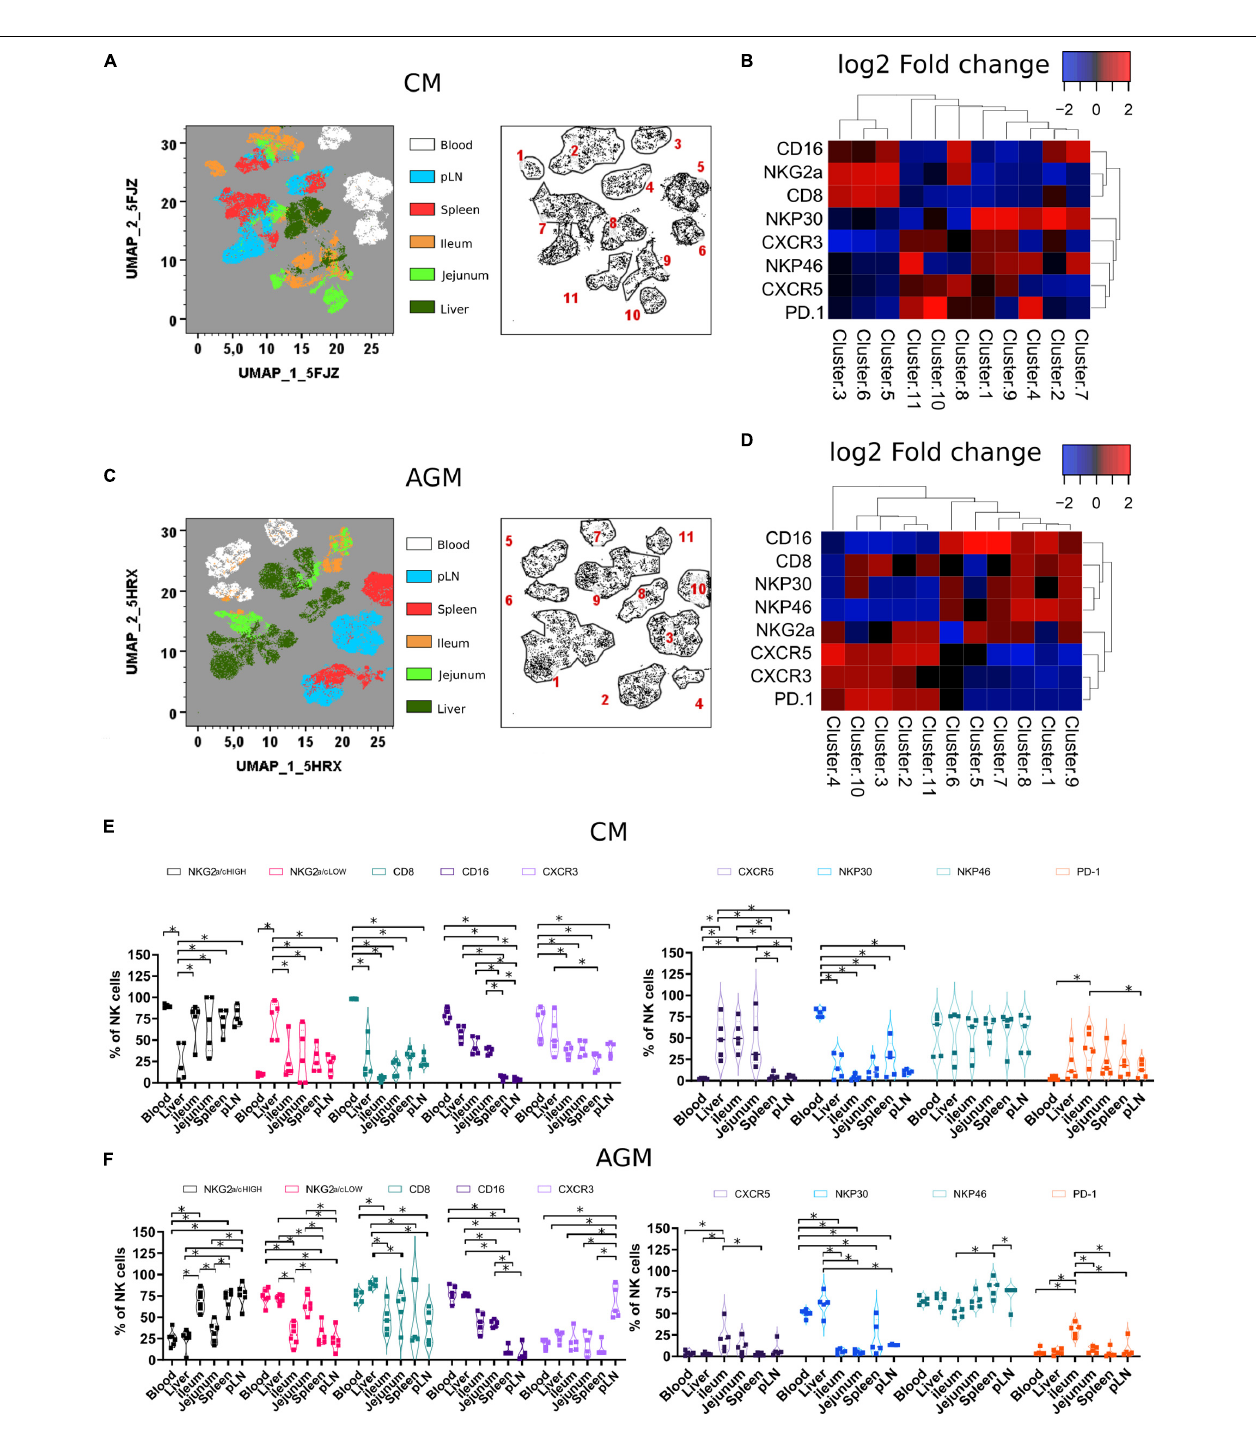
FIGURE 2 | Tissue localization shapes the phenotype of NK cells (A) Force-directed plot showing the relationship between NK cells from distinct tissues identified by multidimensional analysis (data compiled from five healthy CM). Each node is an aggregation of phenotypically similar cells. Resulting from several steps, including downsampling, merging, and overall dimension reduction followed by gating (left panel), and collection of similar nodes forms 11 distinct NK cell clusters (right panel). (B) Heatmap showing the differential expression of cell surface markers used for clustering and community identification in the multidimensional analysis in panel (A) . (C) Same analyses as in panel (A) performed on six healthy AGM. (D) Heatmap showing the differential expression of cell surface markers used for clustering and community identification in the multidimensional analysis in panel (C) . (E,F) Vioplots showing the distribution of markers on bulk tissue NK cells from (E) healthy CMs and (F) healthy AGMs. Each marker is labeled with a unique color. All comparisons were carried out using a one-way analysis of variance (ANOVA) and followed by a Tukey’s multiple-comparison test. The latter is a post hoc test based on the studentized range distribution. Median and standard error bars are shown. Asterisks indicate a p -value <